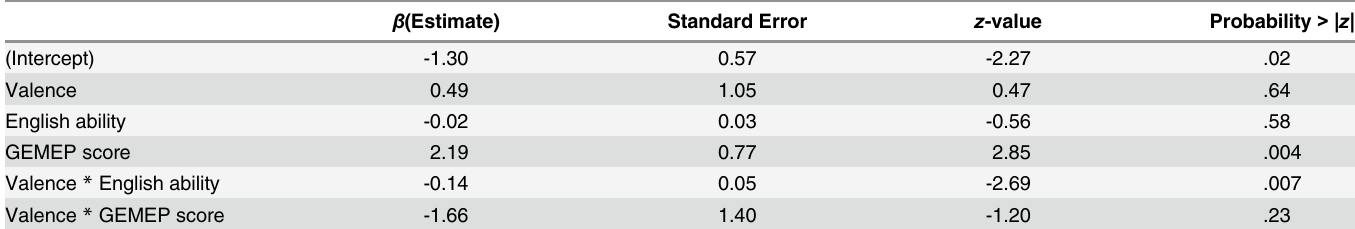
Table 2. Results from emotional prosody condition.